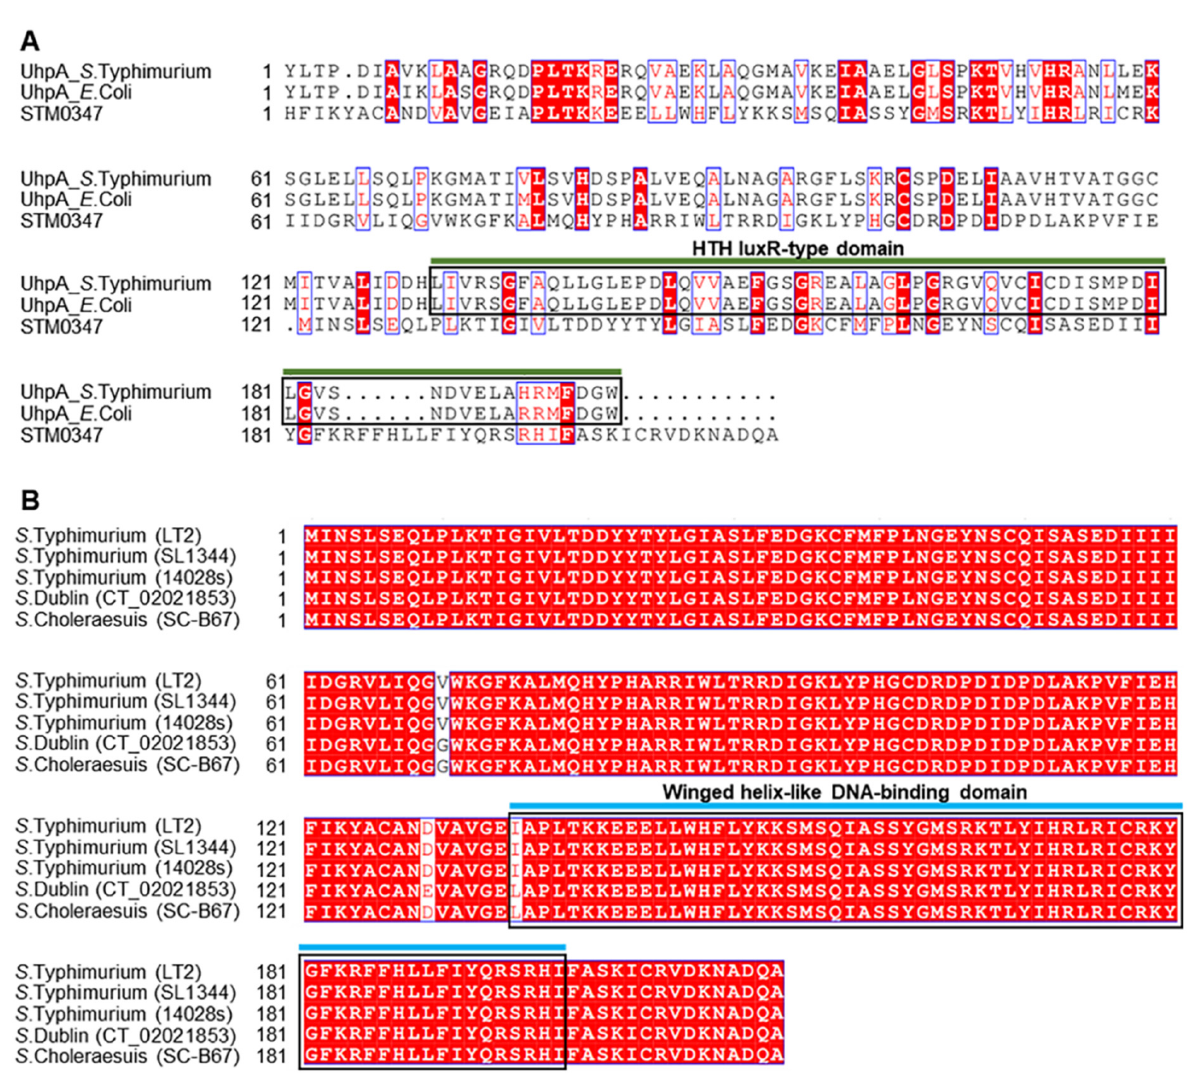
Figure 1. Homology analysis of STM0347 protein. Homologous proteins STM0347 were blasted with the NCBI database (https://blast.ncbi.nlm.nih.gov/Blast.cgi, accessed on 16 October 2021), multiple sequences of STM0347 with its homologs from different bacteria or different Salmonella strains were aligned by the CLUSTALW program (http://www.genome.jp/tools/clustalw/), and the figures were portrayed with ENDscript Web server (https://espript.ibcp.fr/ESPript/cgi-bin/ESPript.cgi, accessed on 16 October 2021) [26].